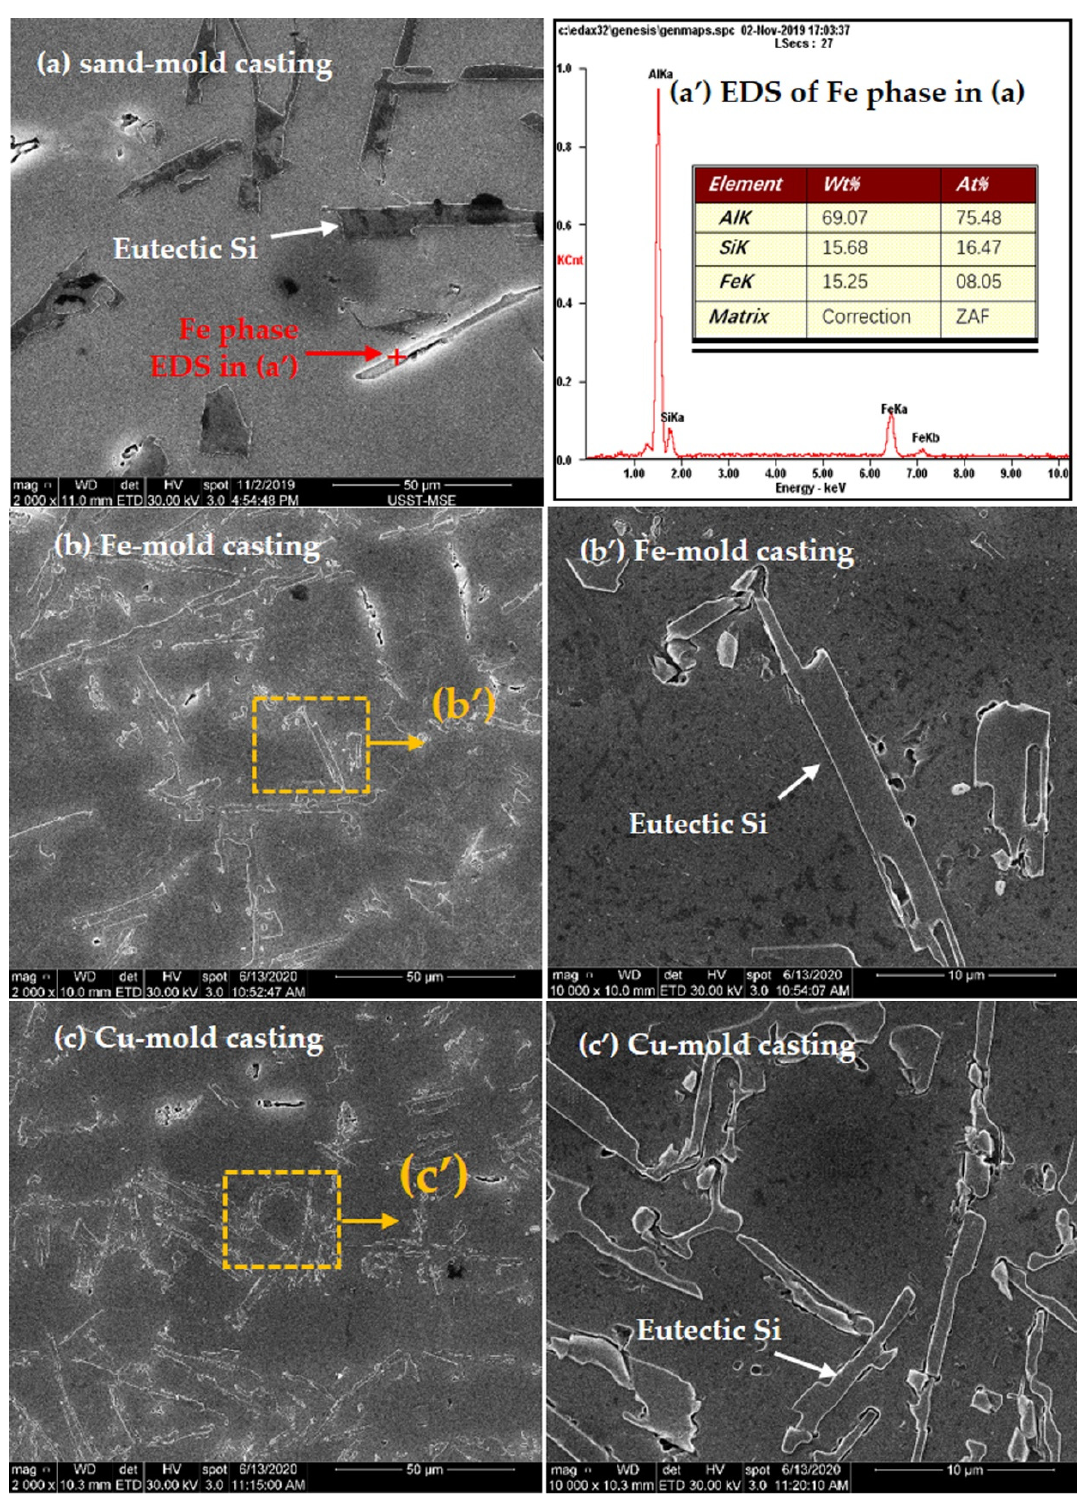
Figure 7. SEM microstructures of Al-10Si-0.5Mg alloys prepared with: ( a , a’ ) sand-mold, ( b , b’ ) Fe- mold, and ( c , c’ ) Cu-mold. ( a’ ) shows the Fe-rich phase in sand-cast alloy; ( b’ ) and ( c’ ) show the enlarged view of selected area in ( b ) and ( c ), respectively.